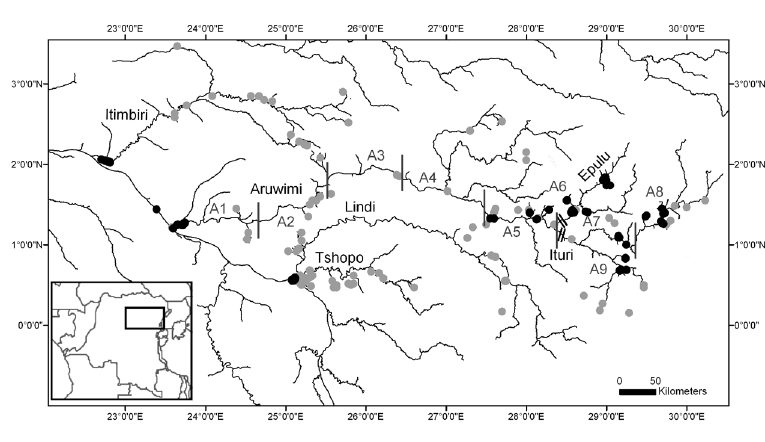
Fig. 1. Map of the area with the north-eastern tributaries of the Congo basin studied; sampling regions of the recent expeditions executed between 2009 and 2014 are indicated (●), as well as the localities of older collection material from the Royal Museum for Central Africa ( ●), and the 130 km segments within the Aruwimi basin (see text); the waterfalls on the Epulu and the Ituri are indicated with two parallel lines; inset map shows the position of the explored region in the Democratic Republic of the